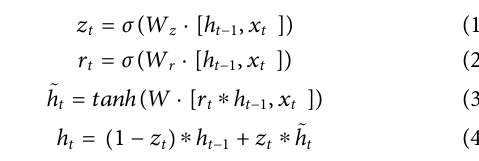
Frontiers in Bioengineering and Biotechnology |